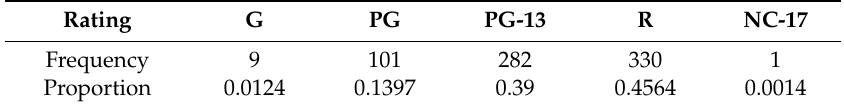
Table 2. Rating Information during Years 2010–2015.